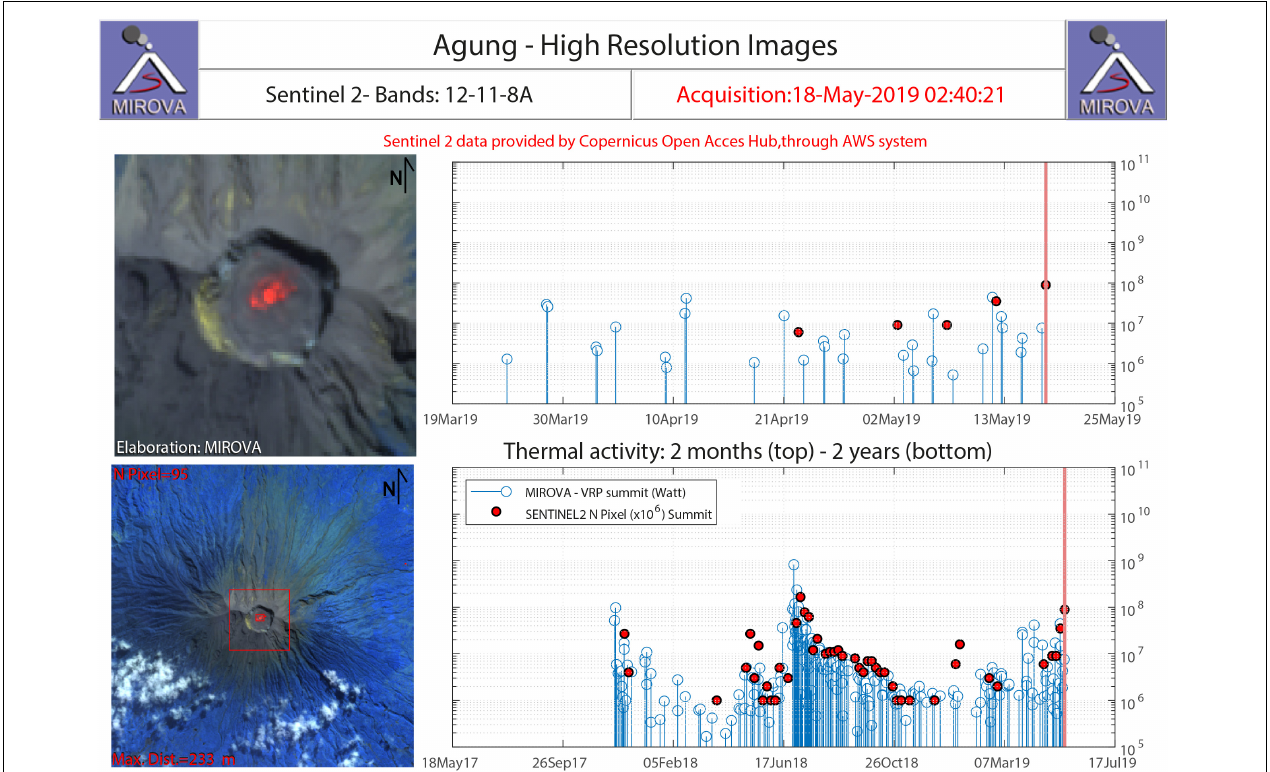
FIGURE 11 | Example of integration of MODIS-MIROVA (1 km) and SENTINEL2 (20 m) thermal data. The panels on the left show the SENTINEL 2 image of 18 May 2019 (combination of bands 12, 11, 8A) acquired over Agung volcano (Indonesia). On the top-left is shown a zoomed view of the crater area (2 km × 2 km) enhancing the presence of a hot lava body. The panels on the right show the MIROVA thermal flow time series (stems) and SENTINEL 2 hot pixel number (circles) of the last 2 months (high) and 2 years (low). The red circles represent the extension of the thermal anomaly within the Agung crater (N Pixel × 10 6 ). Note the excellent correlation between the volcanic radiative power, measured by the MODIS, and the extent of the anomaly (number of hot pixels), detected by SENTINEL